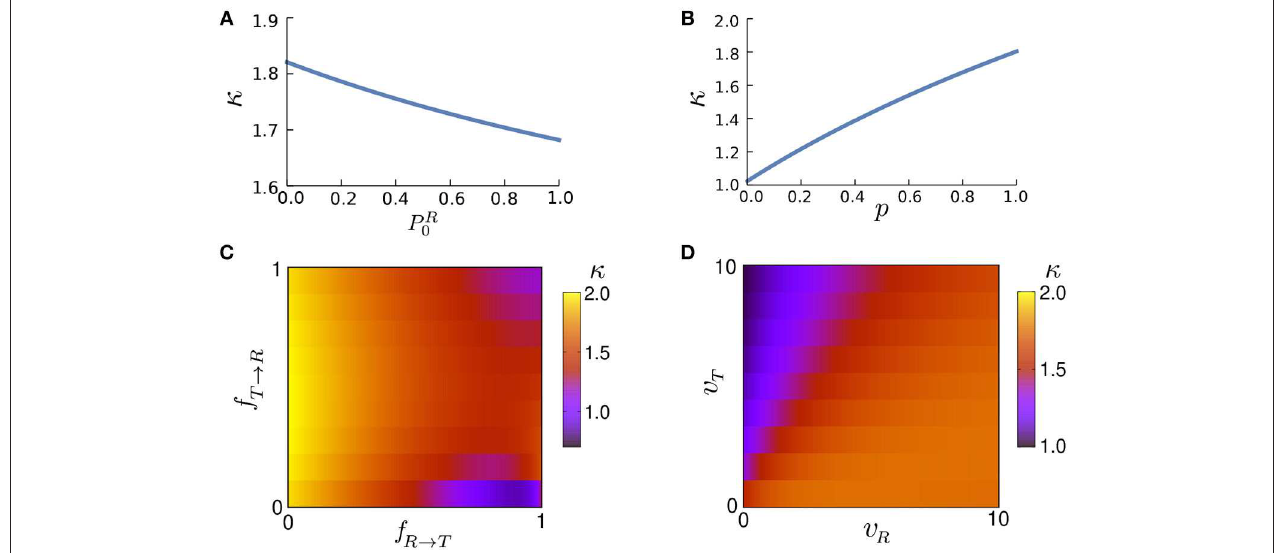
FIGURE 6 | The anomalous exponent κ vs. (A) the initial condition of motion P R 0 , (B) run persistency p , (C) transition probabilities f and v T via Equation (19). The parameter values (unless varied) are taken to be p = 0.9, v R = 10, v T = 1, 1 t = 1, f